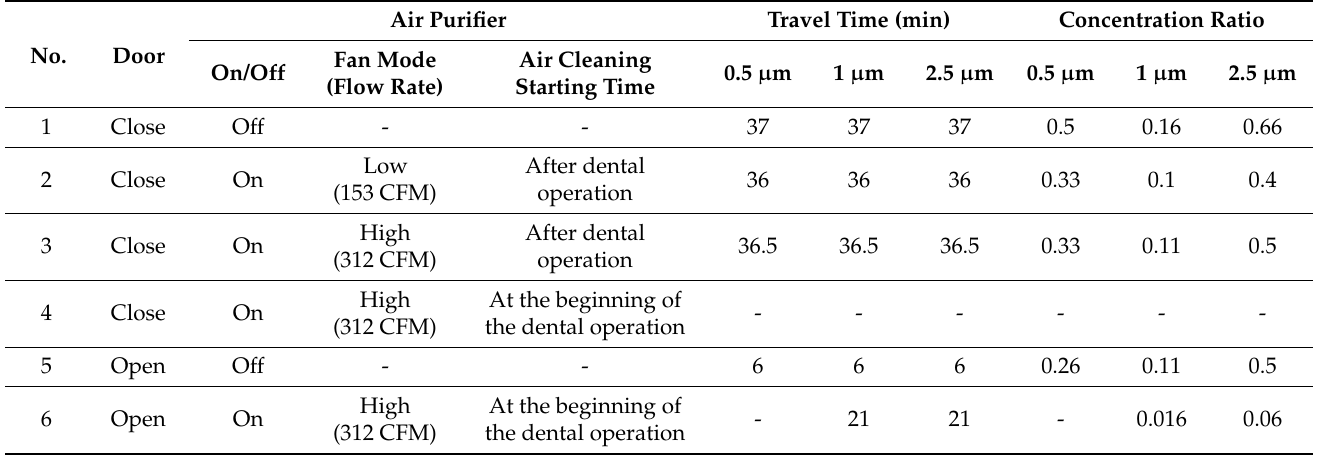
Table 5. The travel time and concentration ratios of 6 cases at the corner of the dental